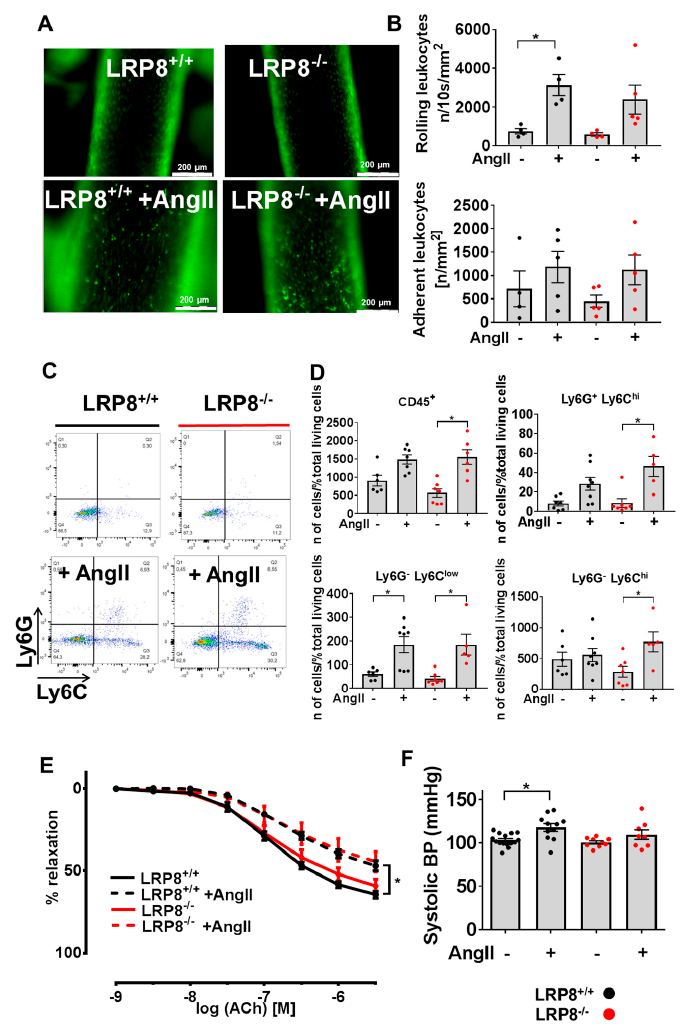
Figure 1. Vascular function and immune cell infiltration in LRP8 +/+ and LRP8 − / − mice in response to AngII. LRP8 +/+ and LRP8 − / − mice were infused with AngII (1 mg / kg / d for 7 d) vs. sham treatment. ( A ) Epifluorescence intravital epifluorescence video microscopy (IVM) of endothelial adherent and rolling leukocytes in the common carotid artery. Nucleated cells were visualized with acridine orange (green fluorescence) (scale bar 200 µ m). ( B ) Quantification of adherent and rolling leukocytes. Cell recruitment was quantified in four fields of view (100 × 150 µ m) per carotid artery (8 measurements per mouse). Adherent cells were defined in each vessel segment as cells that did not move or detach from the endothelial lining within an observation period of 10 s and presented per mm 2 . One dot corresponds to the mean of 8 measurements in one animal. n = 4–5 animals / group. Data are presented as mean ± SEM; * p < 0.05; vs. sham treatment of the same strain. One-way ANOVA and Bonferroni’s multiple comparison test. ( C , D ) Flow cytometry of aortic lysates. ( C ) Representative original plots. ( D ) absolute numbers of viable CD45 + , CD45 + CD11b + Ly6G + Ly6C − NK1.1 − , CD45 + CD11b + Ly6G − Ly6C low NK1.1 − and CD45 + CD11b + Ly6G − Ly6C hi NK1.1 − cells. Results are expressed as the percentage of positive cells per total living cells. One dot corresponds to one aorta of one animal. n = 6–8 animals / group. Data are presented as mean ± SEM; * p < 0.05; vs. sham treatment of the same strain. One-way ANOVA and Bonferroni’s multiple comparison test. ( E ) Concentration—relaxation curves in response to Acetylcholine (ACh) (endothelium dependent) of isolated aortic segments. One dot corresponds to one aortic ring of one animal. n = 5 animals / group. Data are presented as mean ± SEM; * p < 0.05; vs. sham treatment of the same strain. Two-way ANOVA and Dunn’s multiple comparison test. ( F ) Systolic blood pressure after one week of AngII-infusion or sham treatment. n = 8–14 animals / group. Data are presented as mean ± SEM; * p < 0.05; vs. sham treatment of the same strain; one-way ANOVA and Bonferroni’s multiple comparison